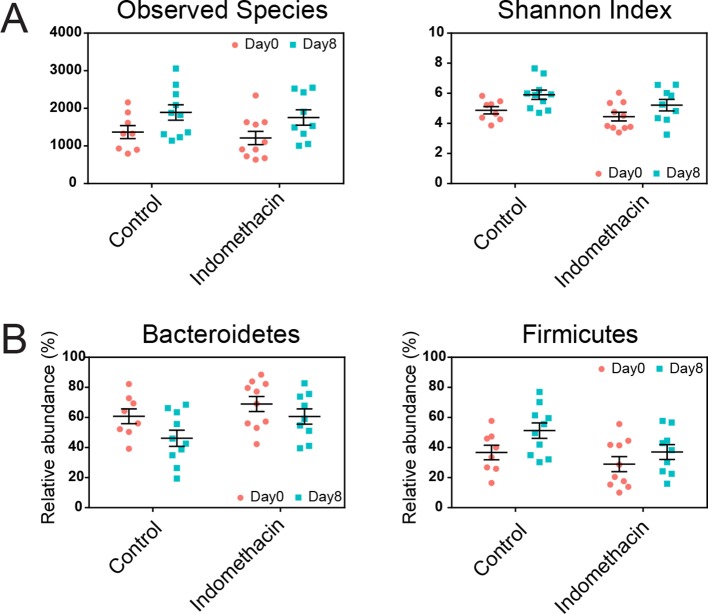
Longitudinal effects of chronic indomethacin treatment in fecal microbiota composition.Fecal microbiota composition before (day 0) and after (day 8) treatment in mice receiving control or indomethacin diet is analyzed by 16S rRNA gene profiling. (A) Observed species (left) and Shannon Index (right) showed no significant difference after indomethacin treatment in both control and indomethacin groups. (B) The relative abundance of Bacteroidetes (left) and Firmicutes (right) showed no significant difference after indomethacin treatment in both control and indomethacin groups. Mann-Whitney test. N=9–10/group. Mean ± S.E.M. shown.